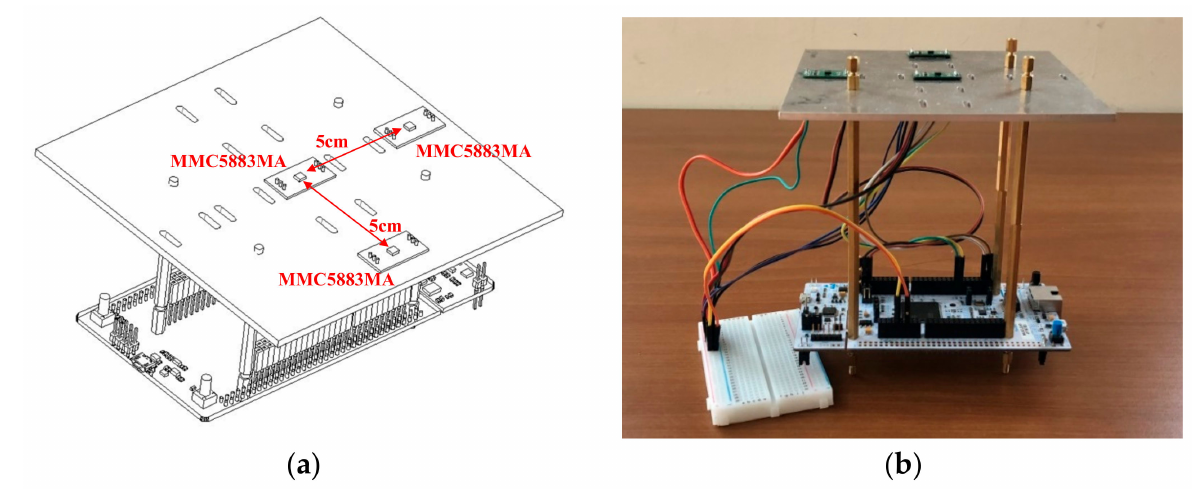
Figure 5. Magnetic sensor array indoor positioning system: ( a ) design and ( b )